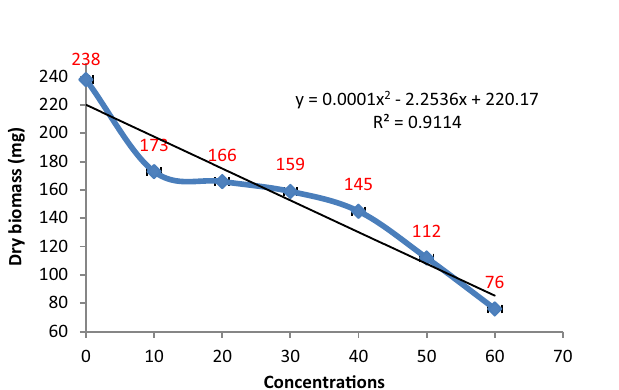
Figure 8. Effect of different metabolite concentrations of P. crustosum on the biomass production of P. herbarum . Vertical bars show standard errors of the means of three replicates.